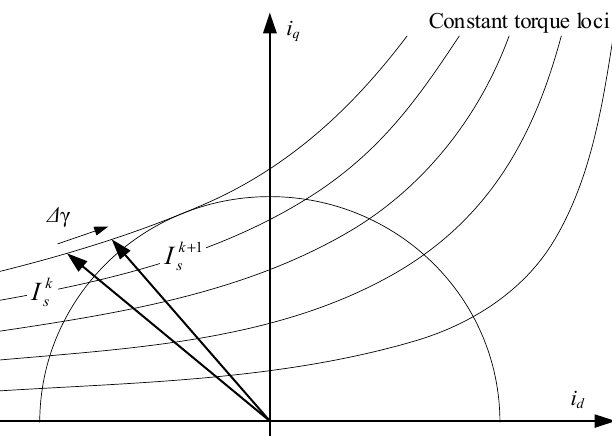
Figure 2. Variation of stator current phase.